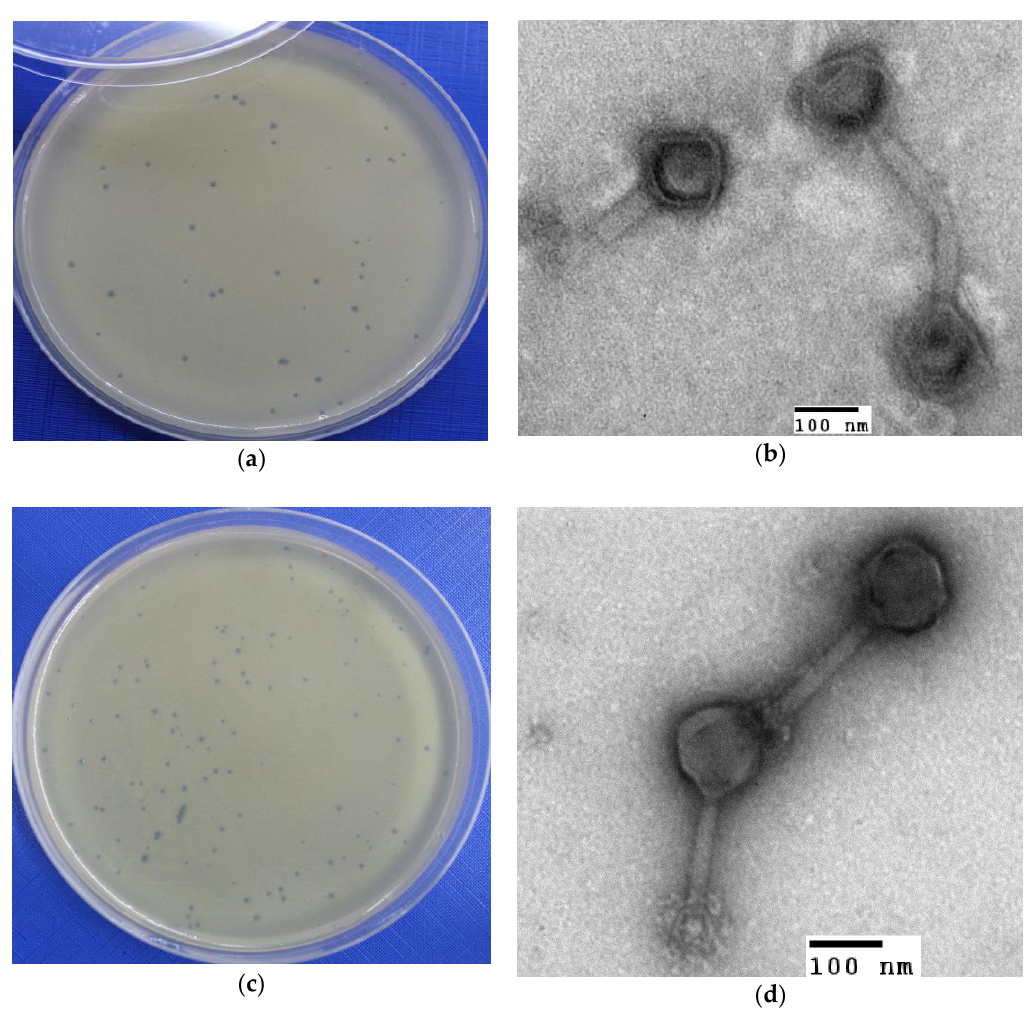
Figure 1. Plaque formation and microphotograph of A. hydrophila phages. ( a , b ) Φ 2 and ( c , d ) phage Φ